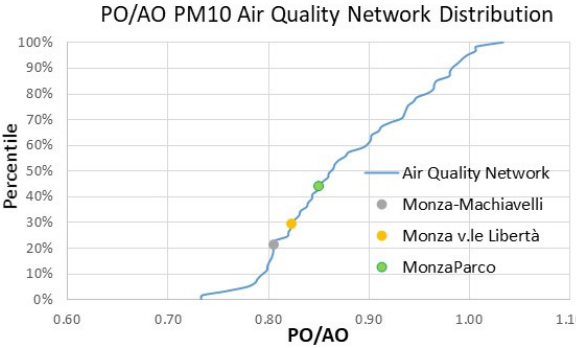
Figure 16: Ratio of the averages AO and PO measured